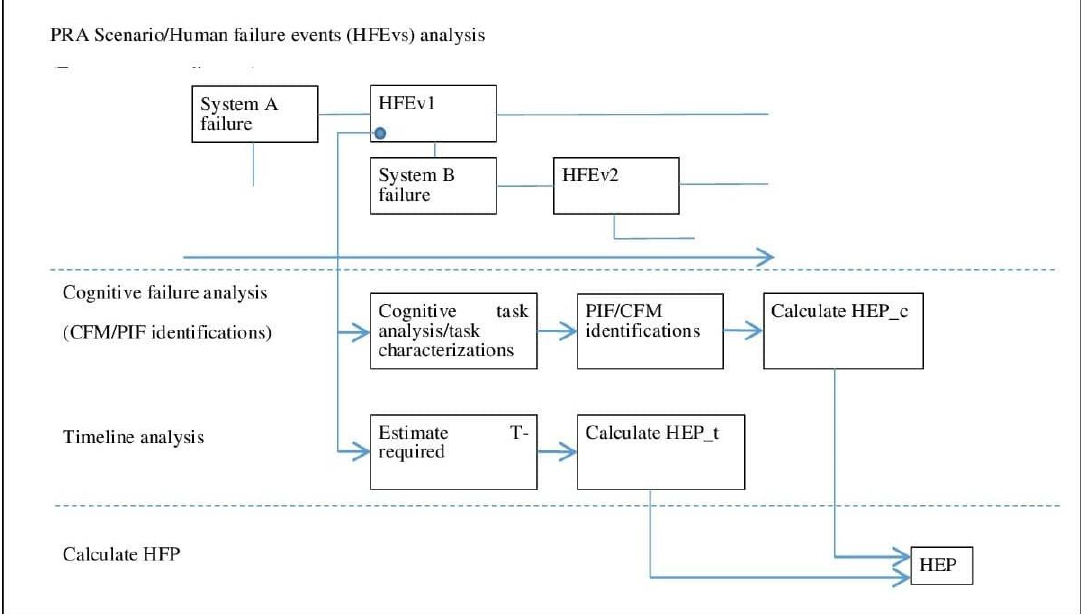
Figure 2. HRA process (U.S.NRC,